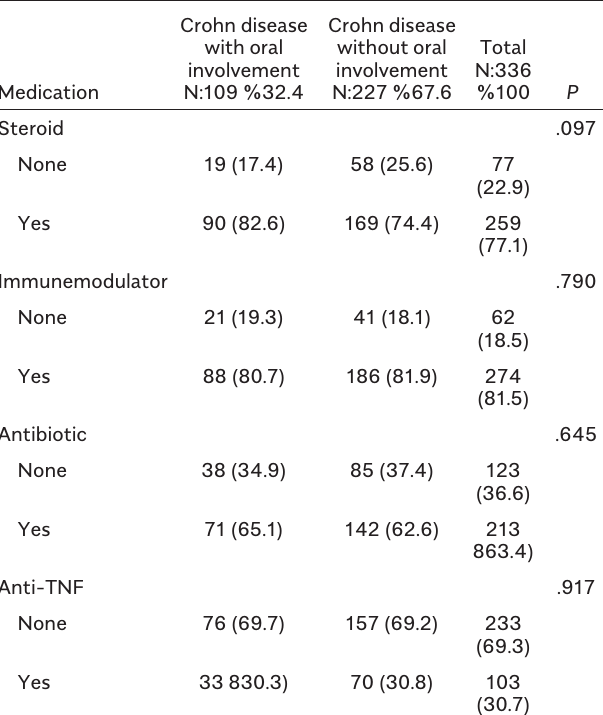
Table 4. The Relationship Between Oral Involvement and Medication in Crohn’s Patients Crohn disease with oral involvement Medication N:109 %32.4